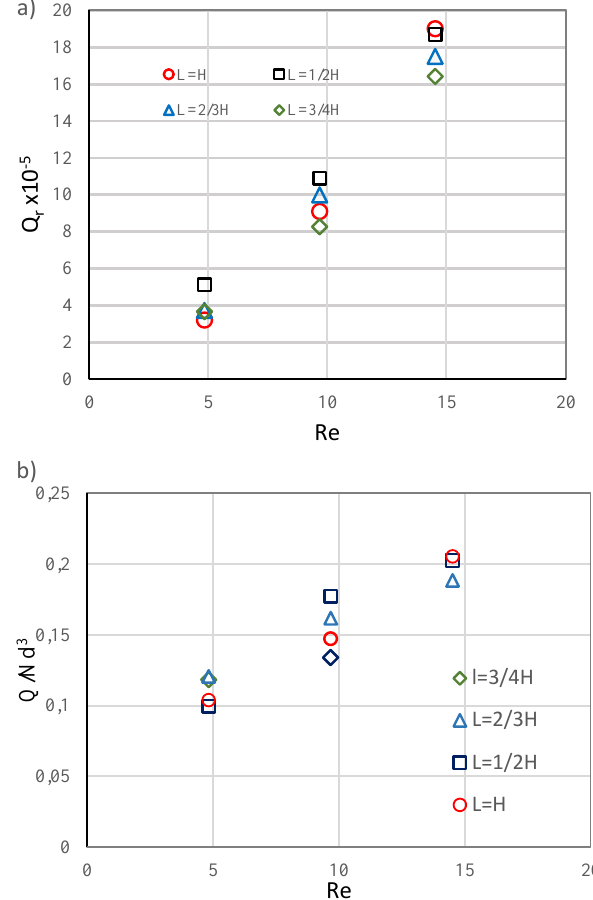
Fig. 3 . (a) Radial pumping capacity Q r for Rushton turbine in function of Reynolds number and for different position of baffles from tank bottom, (b) normalized pumping capacity Q r / N ∙ d 3 .